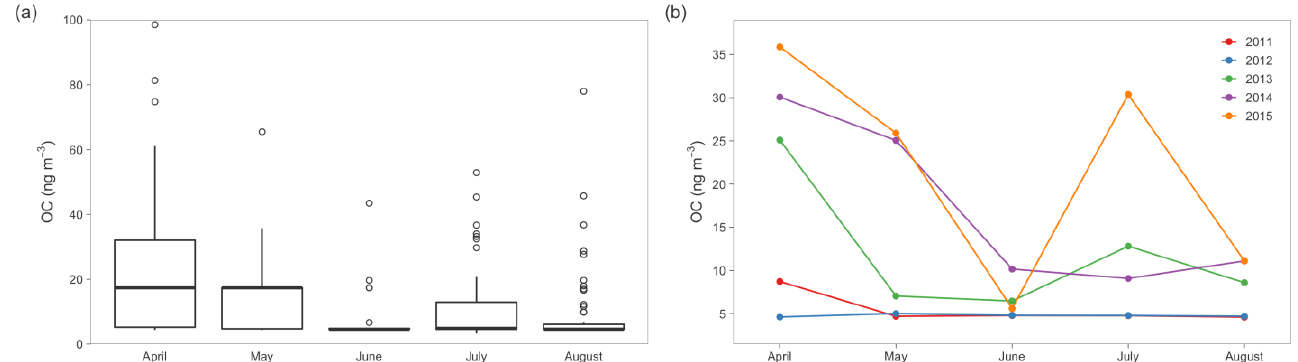
Figure 6. ( a ) EC variation of average monthly concentrations; for whisker plots, see Figure 5 caption. Five values lie above the chosen scale for clarity of visualization. ( b ) EC variation of average monthly concentrations for every single year.